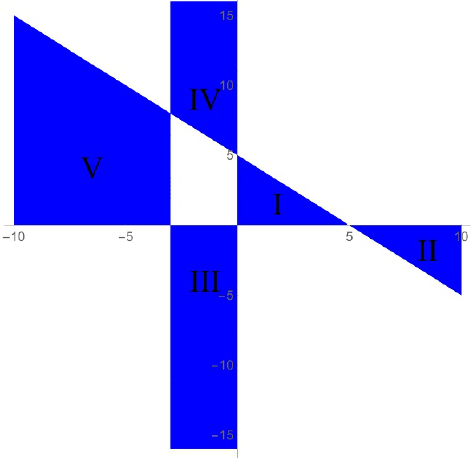
Figure 13 . The (cid:12)ve regions (cid:10) I ; : : : ; (cid:10) V for the maximally cut nonplanar double box with massless internal and external kinematics. The colored area corresponds to F polynomial. The numeric conditions for this plot are s = 3 and t =